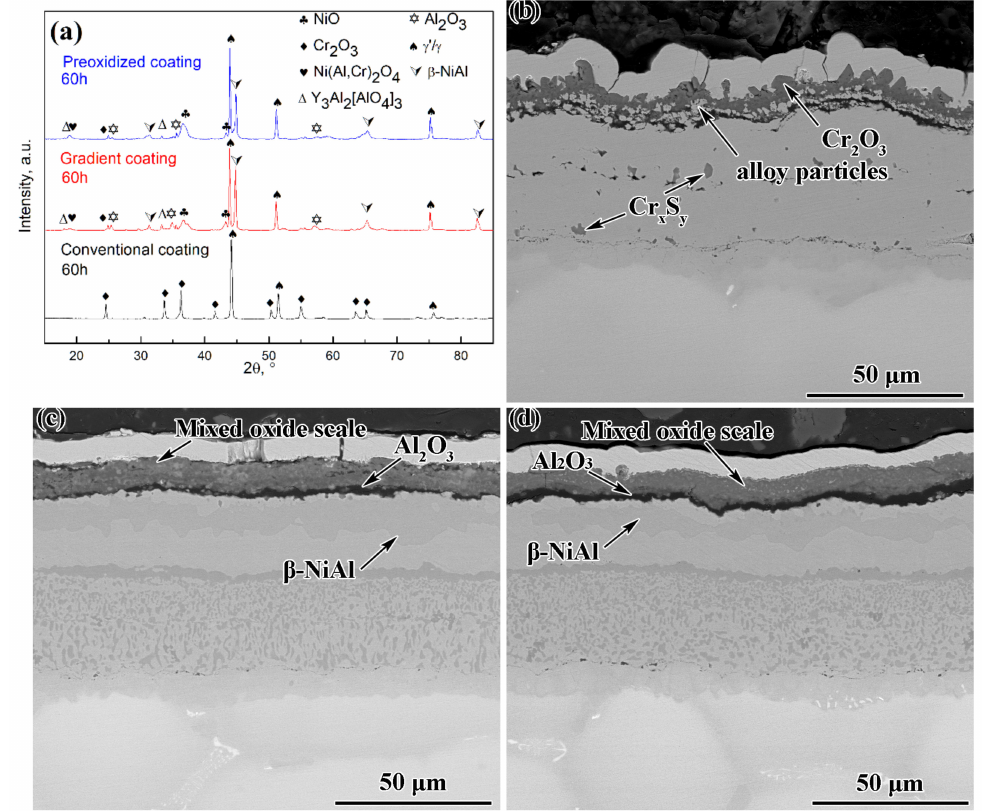
Figure 6. Surface XRD curves and cross-sectional BSE images of the three coatings after the hot corrosion test for 60 h: ( a ) XRD patterns of the three coatings; ( b ) the conventional coating; ( c ) the gradient coating; ( d ) the preoxidised